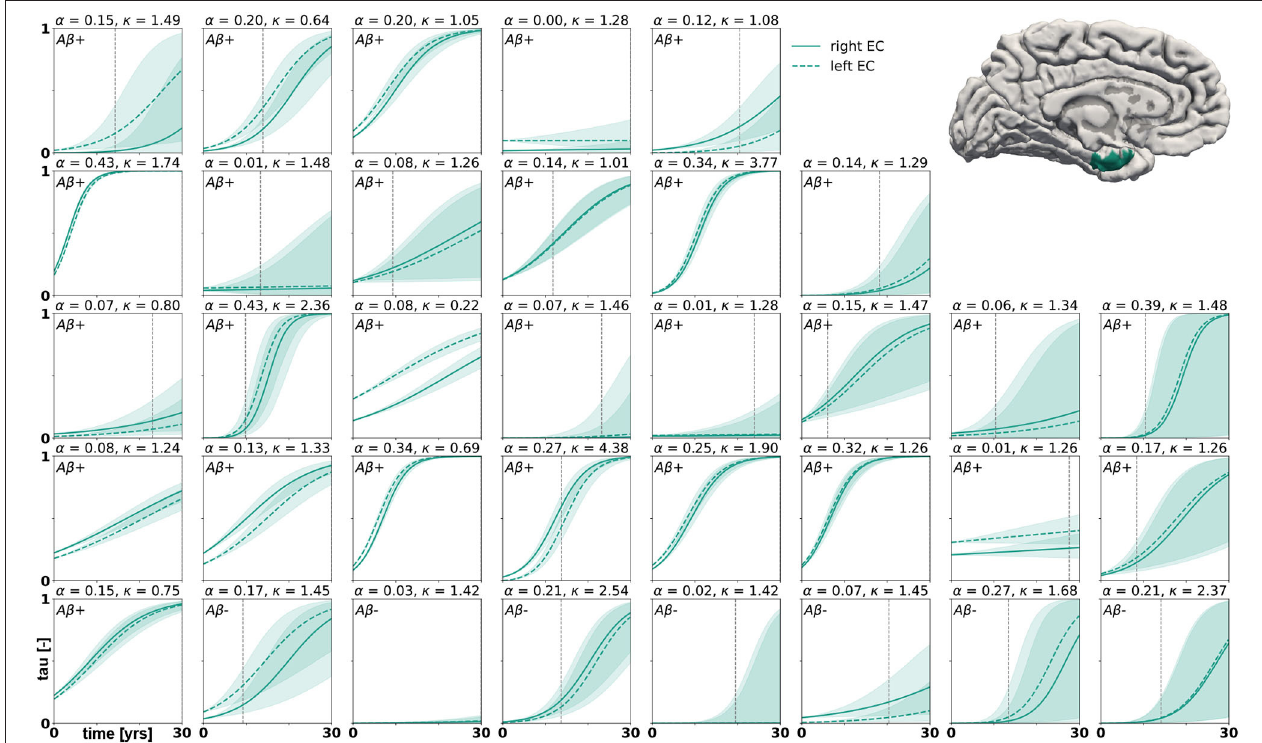
FIGURE 6 | Posterior predictive modeling. Predictions for the change in tau in the entorhinal cortex in 30 years after first tau PET scan for 35 subjects. Shaded areas around the curves represent the 95% credible intervals of the predictions.